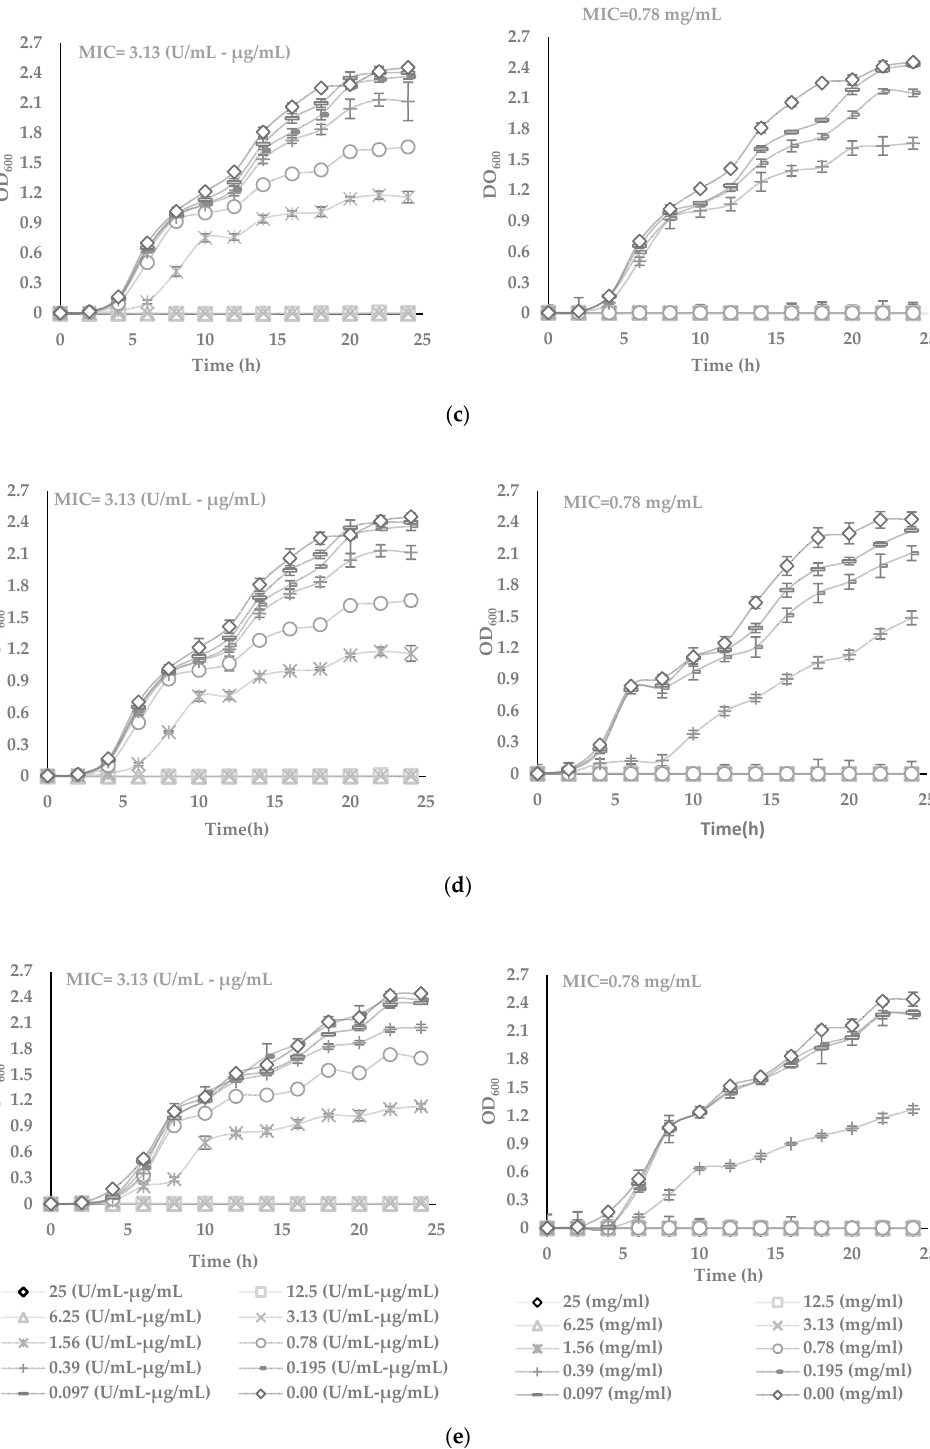
Figure 2. The turbidimetric assay performed in the sterile 96-well plates, in the range of 25 to 0.0097 µ g / mL of AWME and P / S concentrations, in triplicates. Five bacteria strains tested: ( a ) Xanthomonas campestris subsp. campestris; ( b ) Pantoea agglomerans; ( c ) Dickeya solani; ( d ) Pectobacterium carotovorum subsp. carotovorum , and ( e ) Pectobacterium atrosepticum. Minimum inhibitory concentration (MIC) value against bacterial growth was determined for the wells, which appear to stop the growth and remain transparent. Each value represents the mean of three independent experiments ± SD ( n = 3). Di ff erences were considered significant at p <